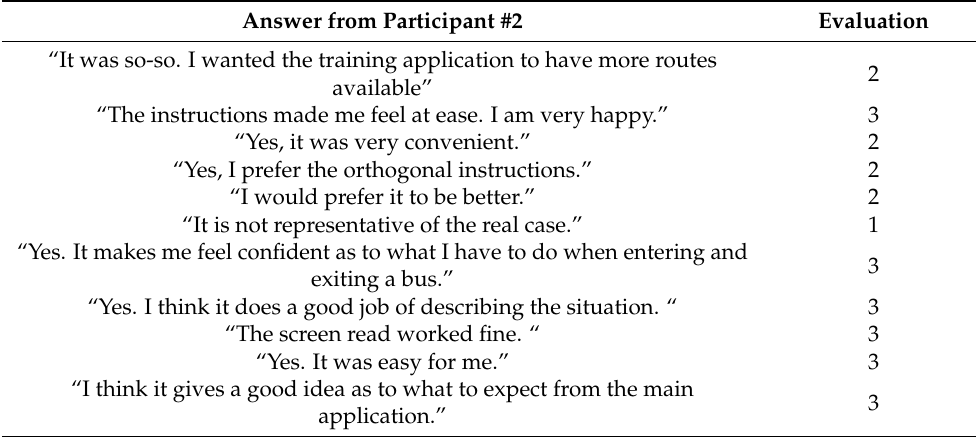
Table 3. Sample of sentiment classifier mappings from answers to